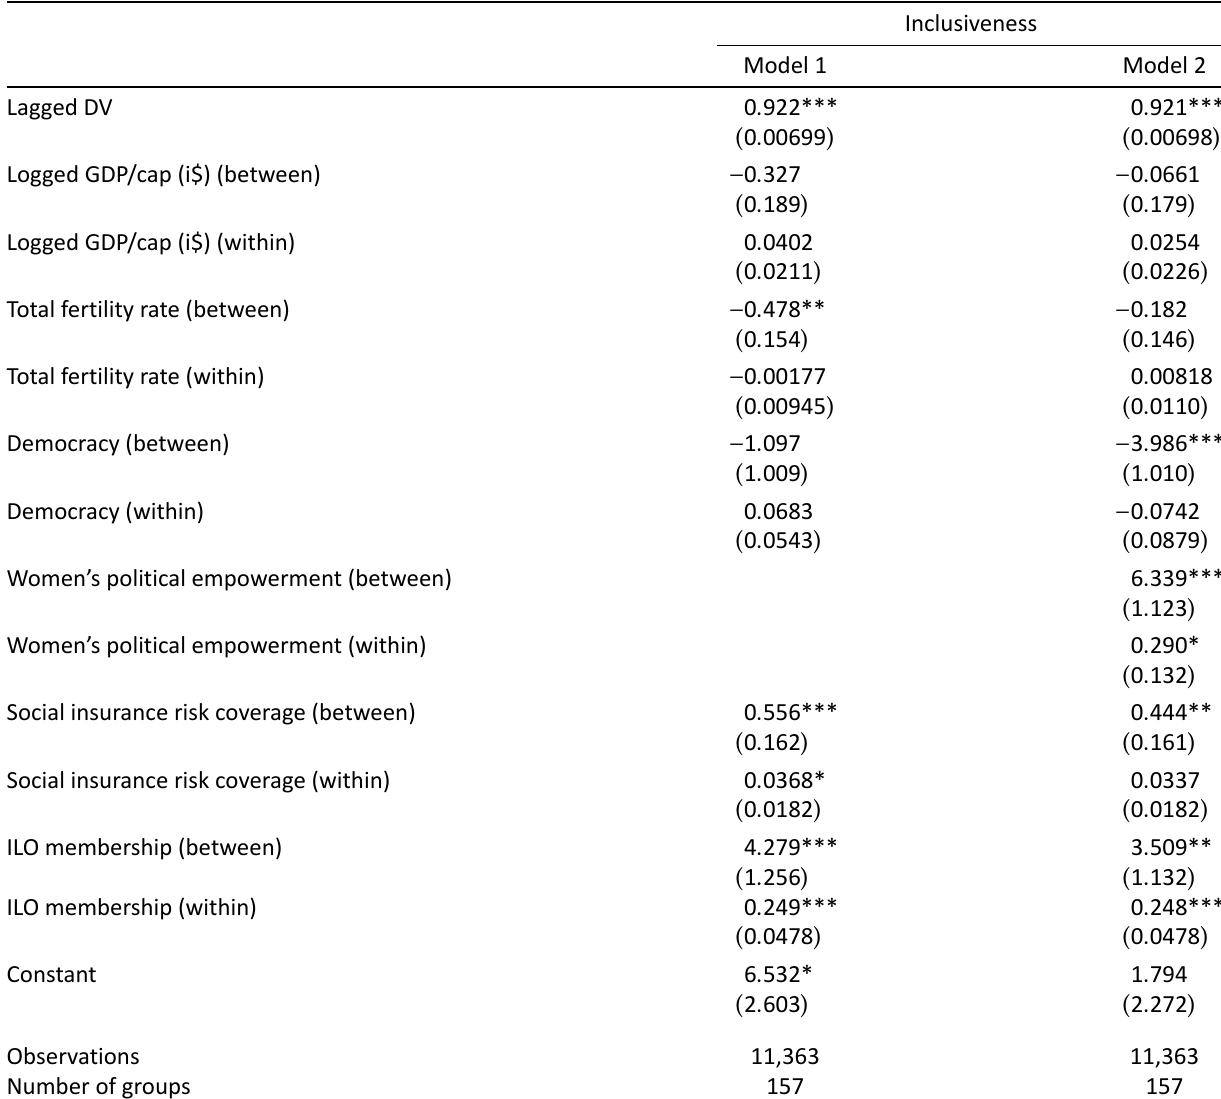
Table 3. Regression